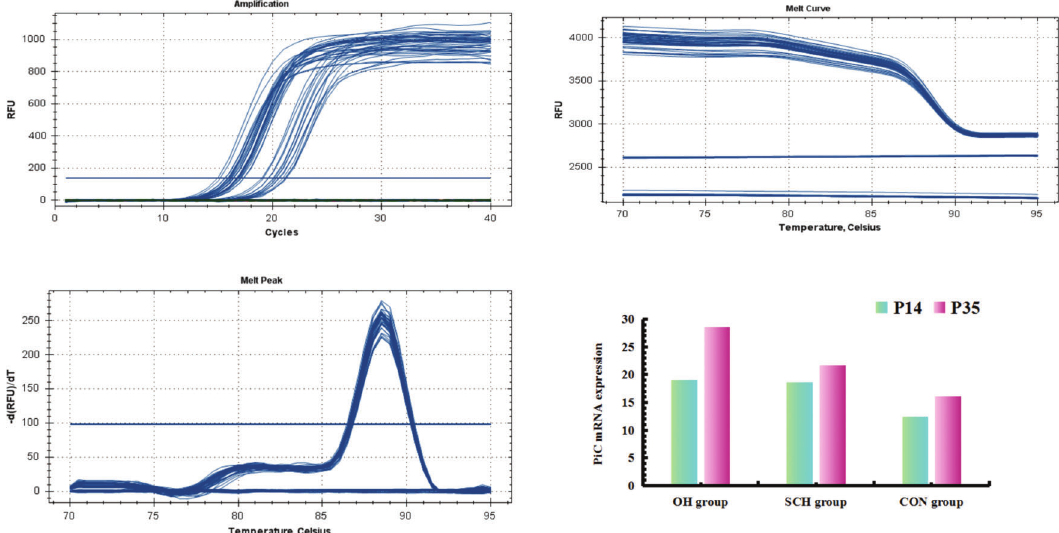
Figure 2 - Comparison of mRNA expression of PiC in offspring rats in the OH group and SCH group. Phosphoric acid carrier vector (PiC); Overall hypothyroidism group (OH); Subclinical hypothyroidism group (SCH).